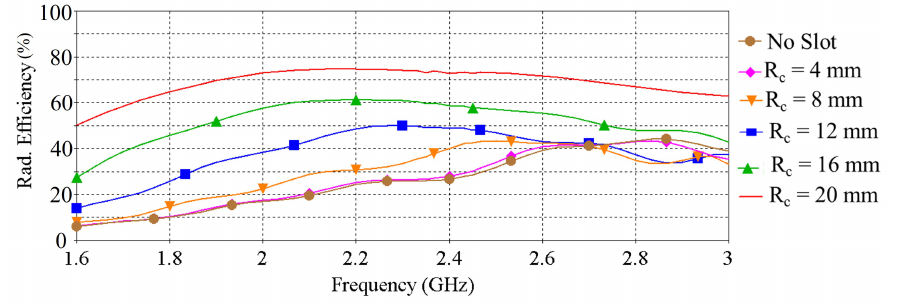
Figure 5. Radiation efficiency vs. frequency when varying the radius of the slot of the ground